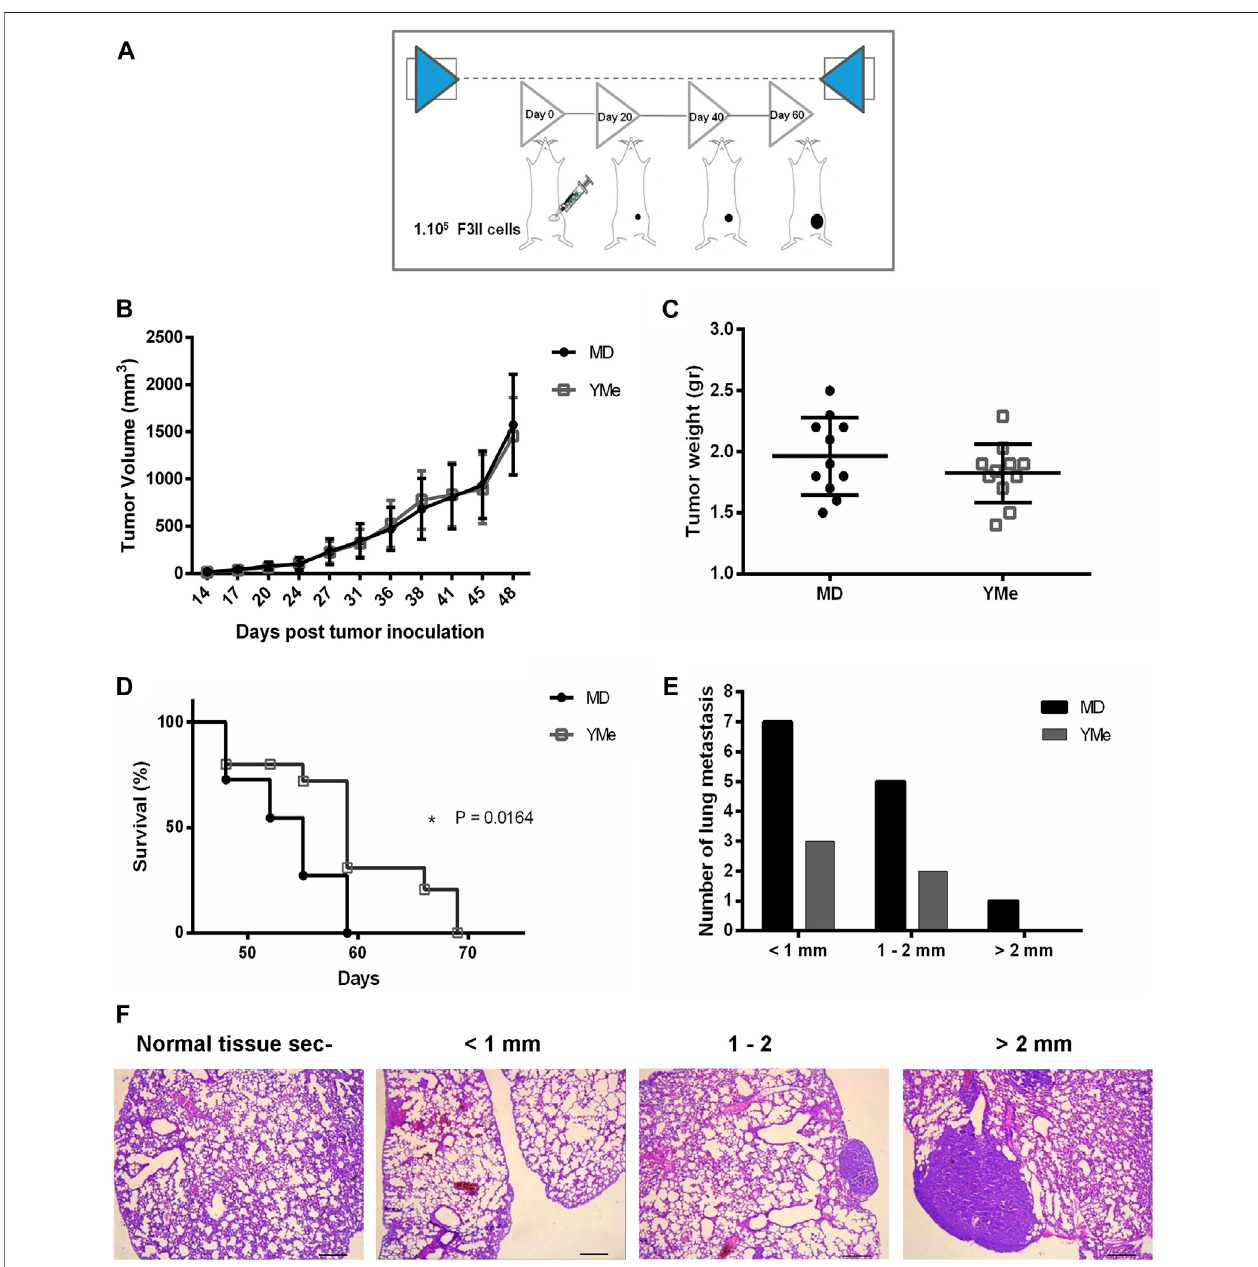
FIGURE5| EffectofYMeontumorprogressioninorthotopicBCmodel.BALB/cmicewererandomlyassignedinto2groups(n (cid:2) 11).ControlgroupdrankMD,the excipient of extract and treated group drank YMe 10 mg/ml. Both solutions were administered to the animals via the drinking water before (1 month) and after the inoculation of F3II tumor cells. The animals were inoculated subcutaneously with 1 × 10 5 cells/mice on left mammary fat pad. At the end of the experiment, mice were sacri fi ced bycervicaldislocationduetoethicalconsiderations. (A) Thetimeline oftheprotocolisoutlined inthescheme. (B) Tumorvolumes, measured periodically with a caliper and calculated with the formula ½ (length x width 2 ) (length > width), are expressed as the mean and analyzed using unpaired Student ’ s t test with Welch ’ s correction. (C) Tumor weight was registered. Unpaired Student ’ s t test was used to detect statistically signi fi cant differences. (D) Kaplan-Meier survival curves of YM- treatedanimalsandcontrols.Statisticalsigni fi cancewascalculatedusinglog-ranktest. (E) Numberoflungmetastasisbasedonsize.Thesizeoflungmetastatictumors wasmeasured with adissecting microscopeand tumors werestrati fi edinto threegroups based on size(diameter < 1 mm small size, 1 – 2 mm medium sizeand > 2mm, large size). The lung nodes of un-treated mice were increased in size compared with the nodes of treated mice. (F) Representative images of lung metastasis. Scale bars, 1 mm.